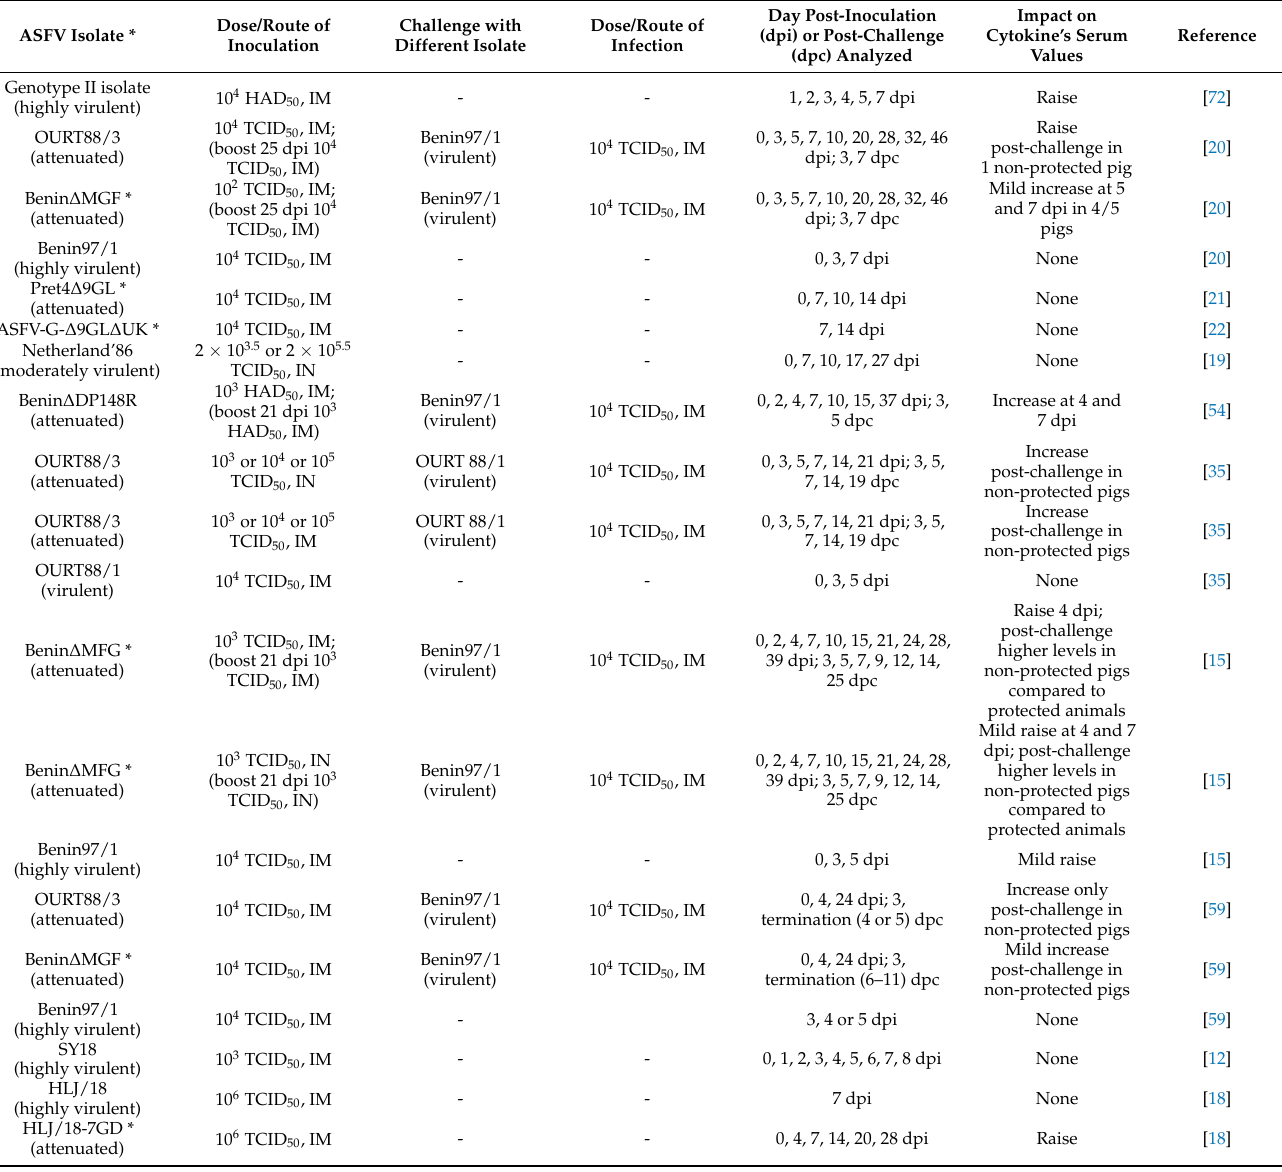
Table 3. Modulation of serum levels of type II IFN in domestic pigs infected with ASFV strains of diverse